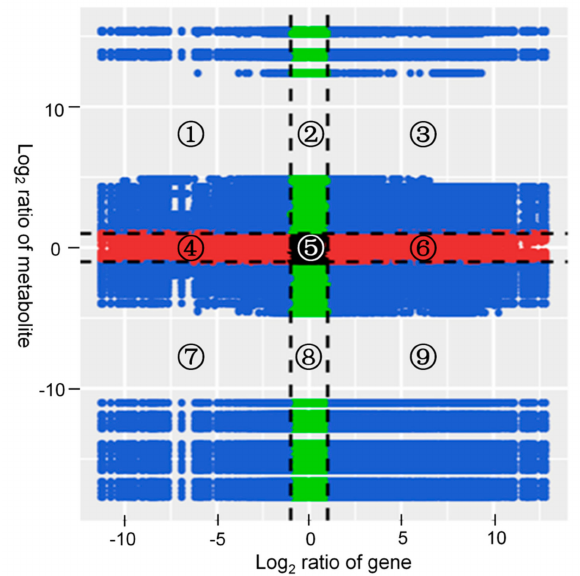
Figure 5. Quadrant diagrams representing the association of the DAMs and DEGs between the non-mycorrhizal and mycorrhizal A. roxburghii growth for six months. The x-axis represents that the log 2 ratio of gene and the y-axis represents the log 2 ratio of metabolite; black dotted lines represent the di ff erent threshold; each point represents a gene or metabolite; black dots represent the unchanged genes or metabolites; green dots represent di ff erentially accumulated metabolites with unchanged genes; red dots represent di ff erentially expressed genes with unchanged metabolites; blue dots represent both di ff erentially expressed genes and di ff erentially accumulated metabolites; it is divided into 1 (cid:79) – 9 (cid:79) quadrants from left to right and from top to bottom with black dotted lines; the 1 (cid:79) , 2 (cid:79) and 4 (cid:79) quadrants indicate that the expression abundance of metabolites is higher than that of genes; the 3 (cid:79) and 7 (cid:79) quadrants indicate that the expression patterns of genes are consistent with the metabolites; the 5 (cid:79) quadrant indicates that the genes and metabolites are not di ff erentially expressed; the 6 (cid:79) , 8 (cid:79) and 9 (cid:79) quadrants indicate that the expression abundance of metabolites is lower than that of